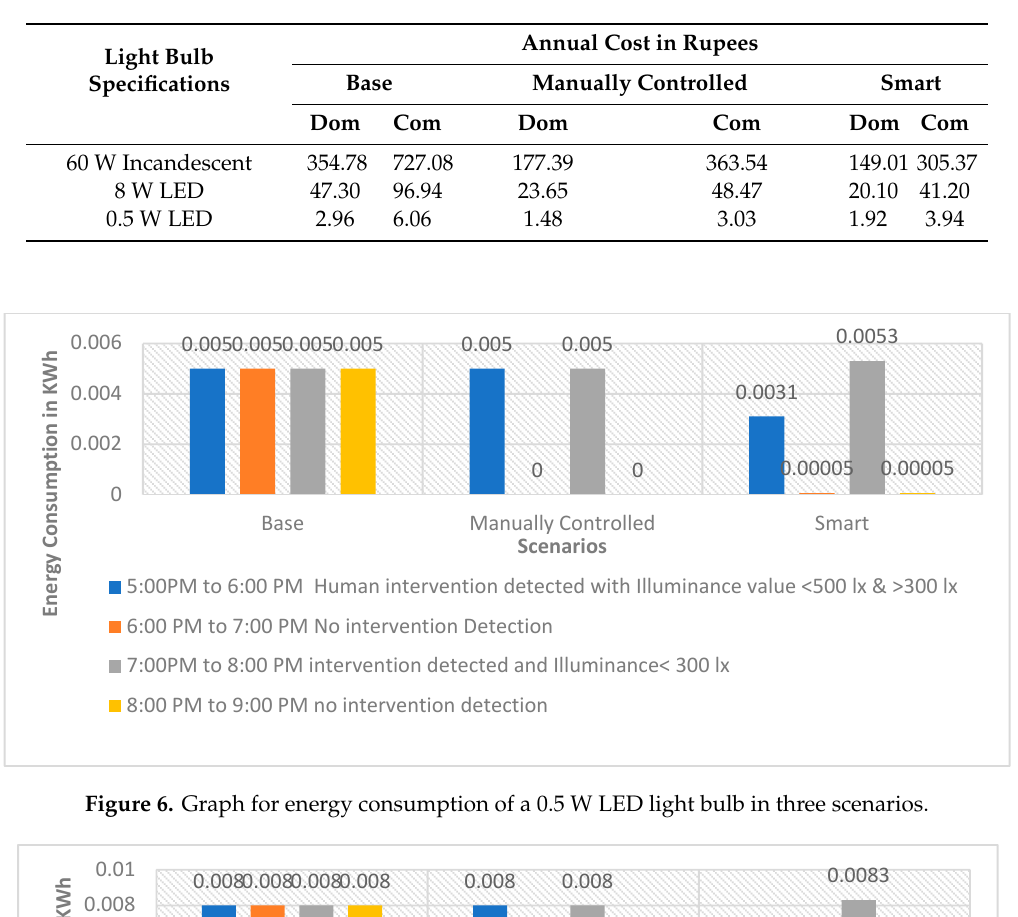
Table 10. Annual cost of three scenarios.